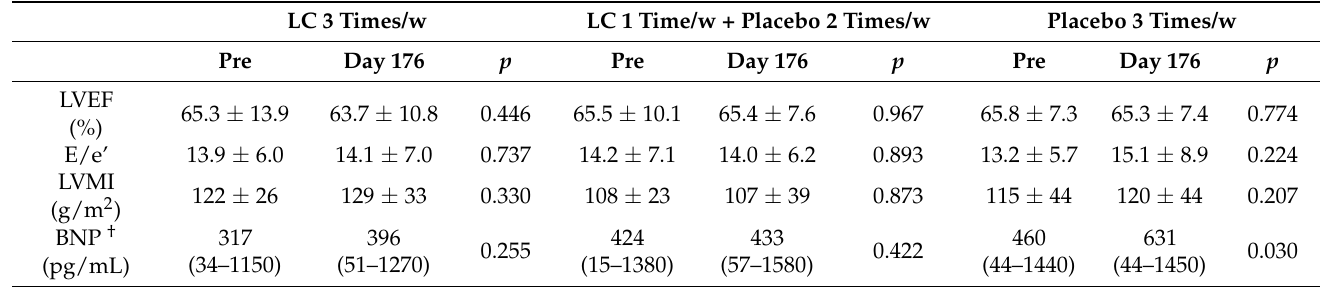
Table 3. Effects of reducing or stopping LC treatment on LV function, LVMI, and BNP levels.